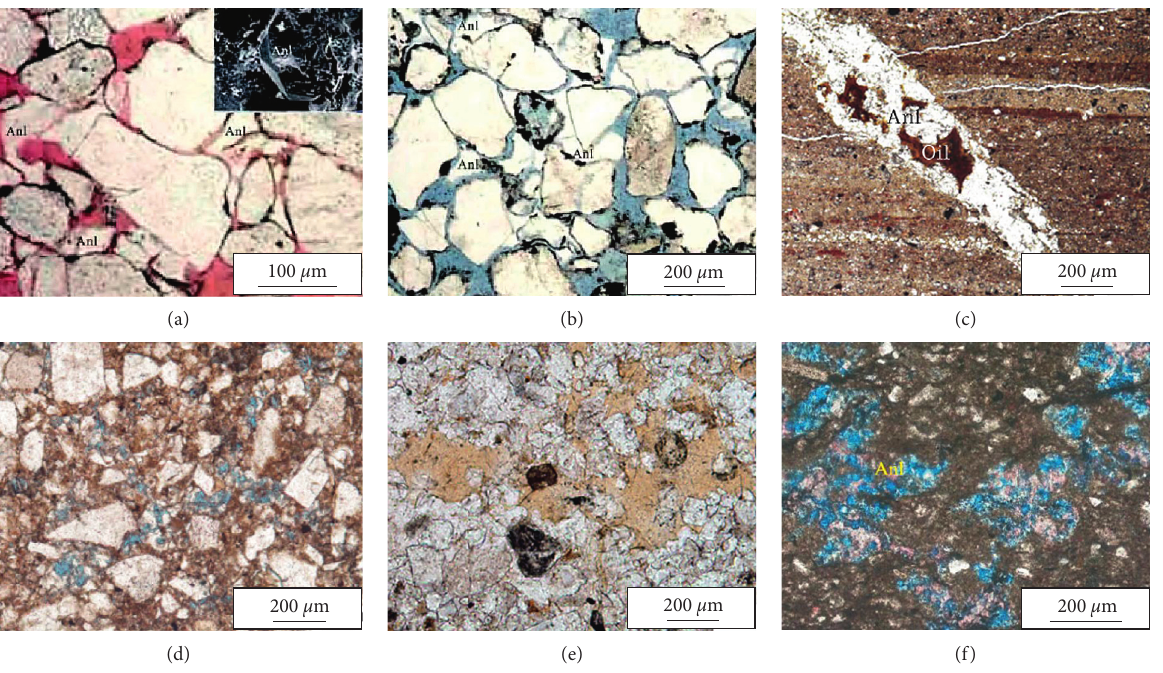
Figure 14: Secondary solution pores of analcime under the precipitation-dissolution mechanism. (a) Intergranular analcime is dissolved and pores are shown in red; the inset shows the corrosion characteristics of analcime under an electron microscope [73]. (b) Intergranular analcime is dissolved and pores are shown in blue [73]. (c) A crack in the layers is filled by analcime and oily asphalt [19]. (d) Analcime dissolution pores in silty sandstone [19]. (e) Secondary pores are formed by strong cementation and local dissolution of sparry analcime in siltstone [19]. (f) Dissolution pores of analcime are developed [20].